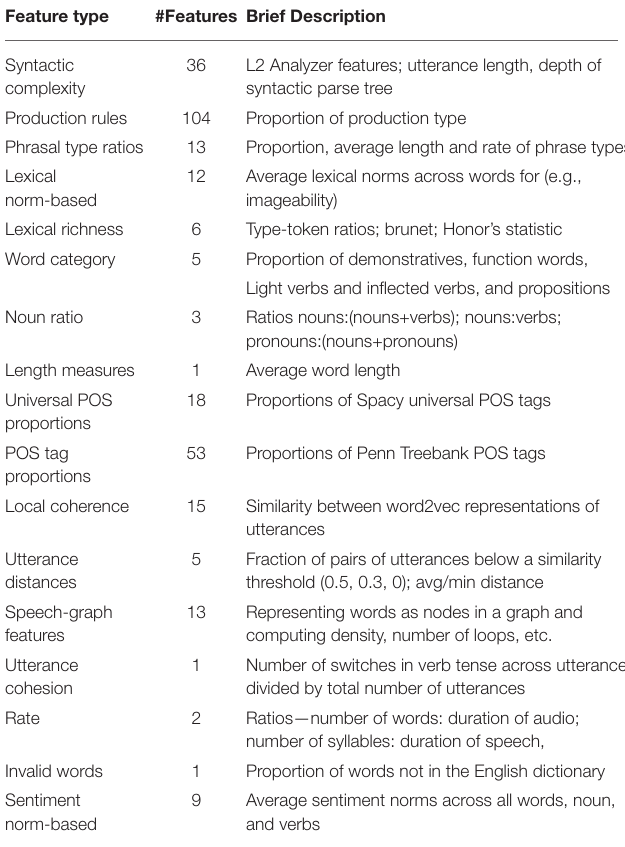
TABLE 4 | Summary of all lexico-syntactic features extracted.